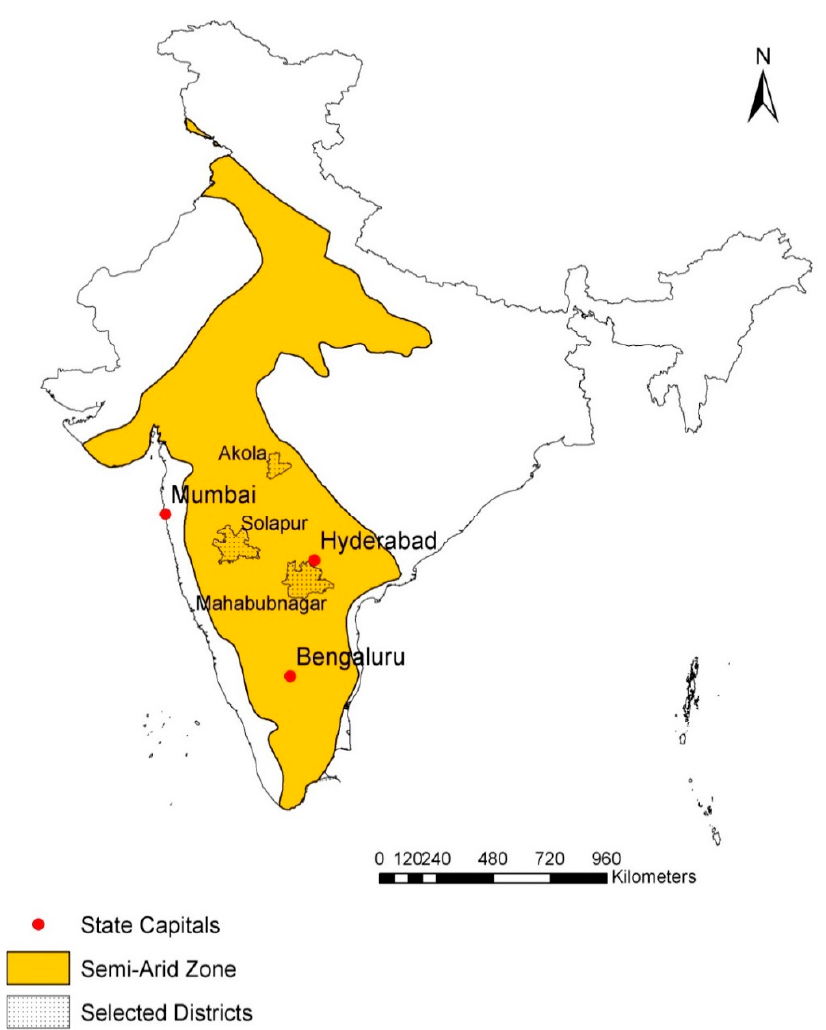
Figure 1. Study area. Since the data is a pooled cross section over three years, variables of monetary value were adjusted for inflation. This adjustment was conducted using India’s consumer price index 2011 as the base year.